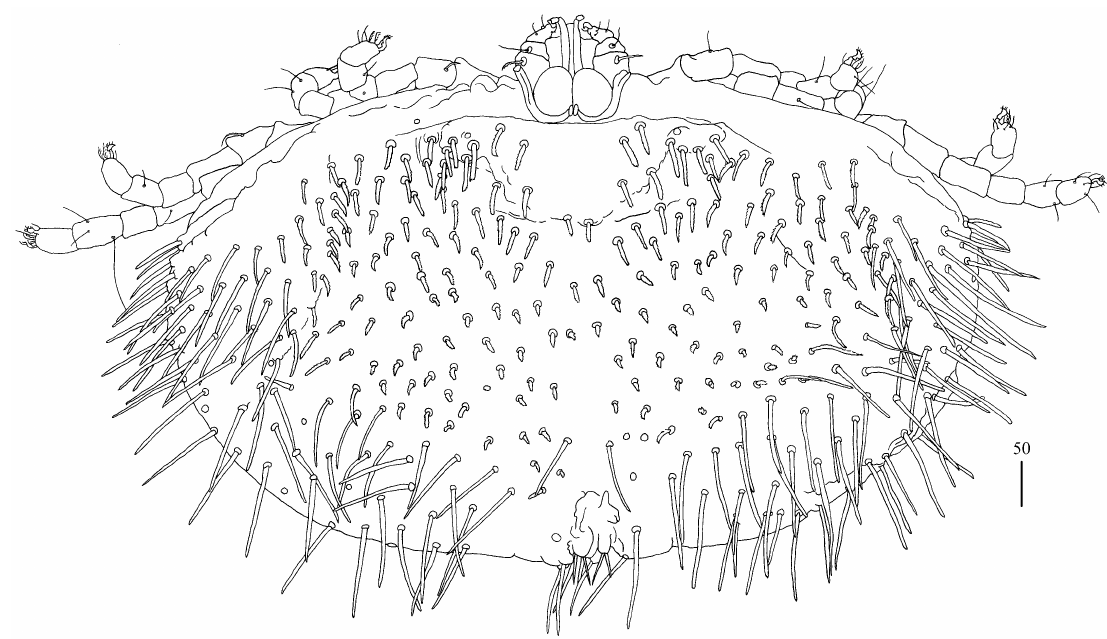
Figure 14. Geckobia brevicephala sp. n. female in dorsal view.